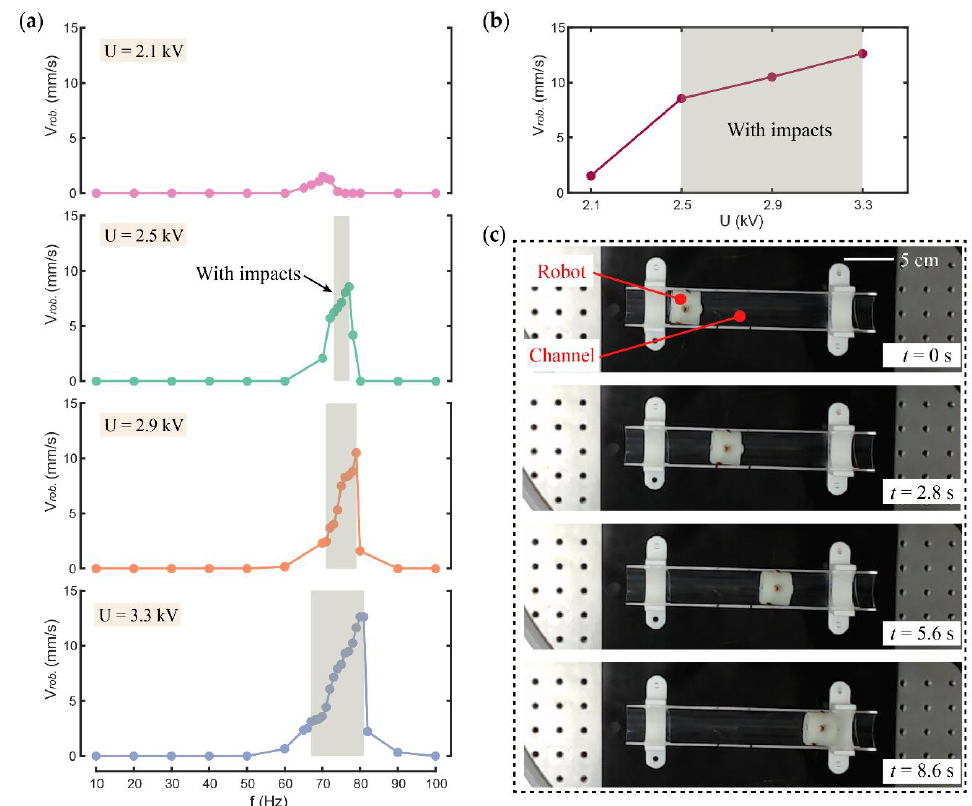
Figure 7. ( a ) Velocity of the robot at different actuation voltage amplitudes and frequencies; ( b ) Maximum velocity of the robot at different actuation voltage amplitudes; ( c ) Snap-shots of robot motion.